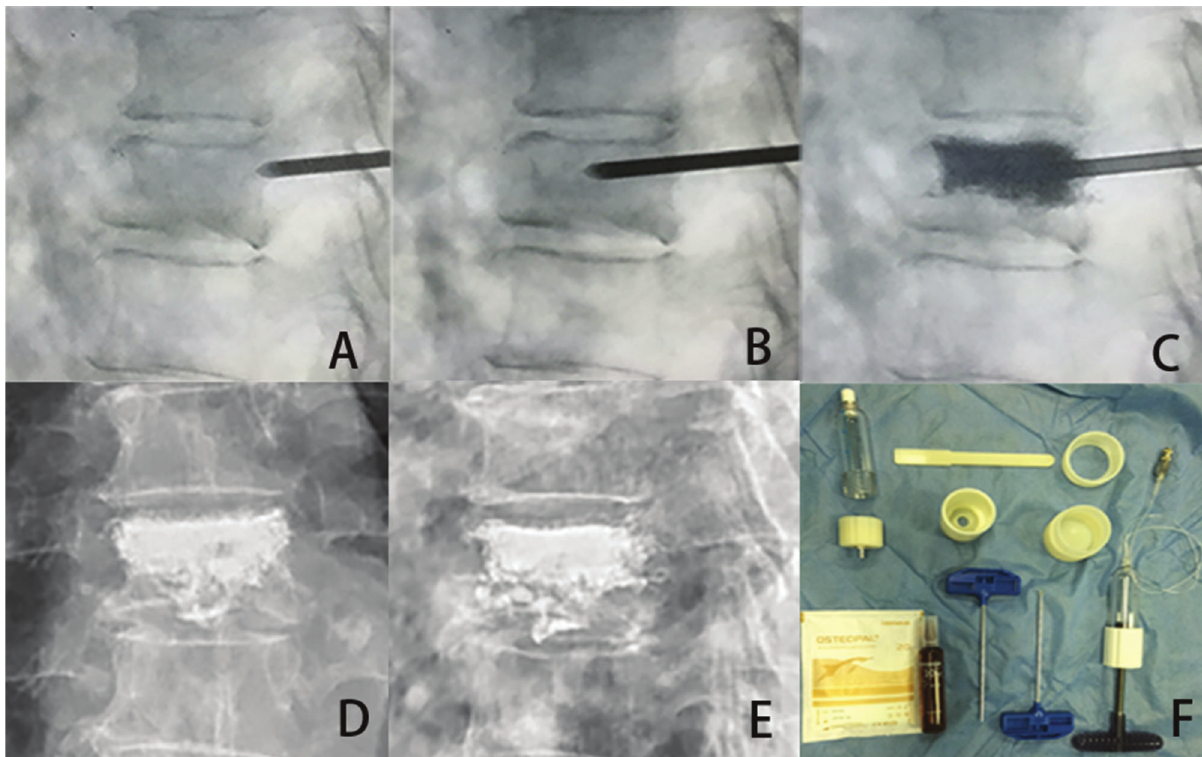
Figure 4 - HPDS surgical procedure for the treatment of a 79-year-old female patient with T8 vertebral body fracture. A, A puncture needle enters into the fractured T8 vertebra via the left pedicle. B, Lateral radiograph showing the puncture needle tip in the anterior column of the vertebral body. C, High-viscosity bone cement is injected into the fractured vertebral body. The lateral radiograph shows the filling of the vertebral body with high-viscosity cement. D and E, Lateral and posterior-anterior X-ray films after the HPDS surgical procedure. F, The HPDS device and high-viscosity cement.